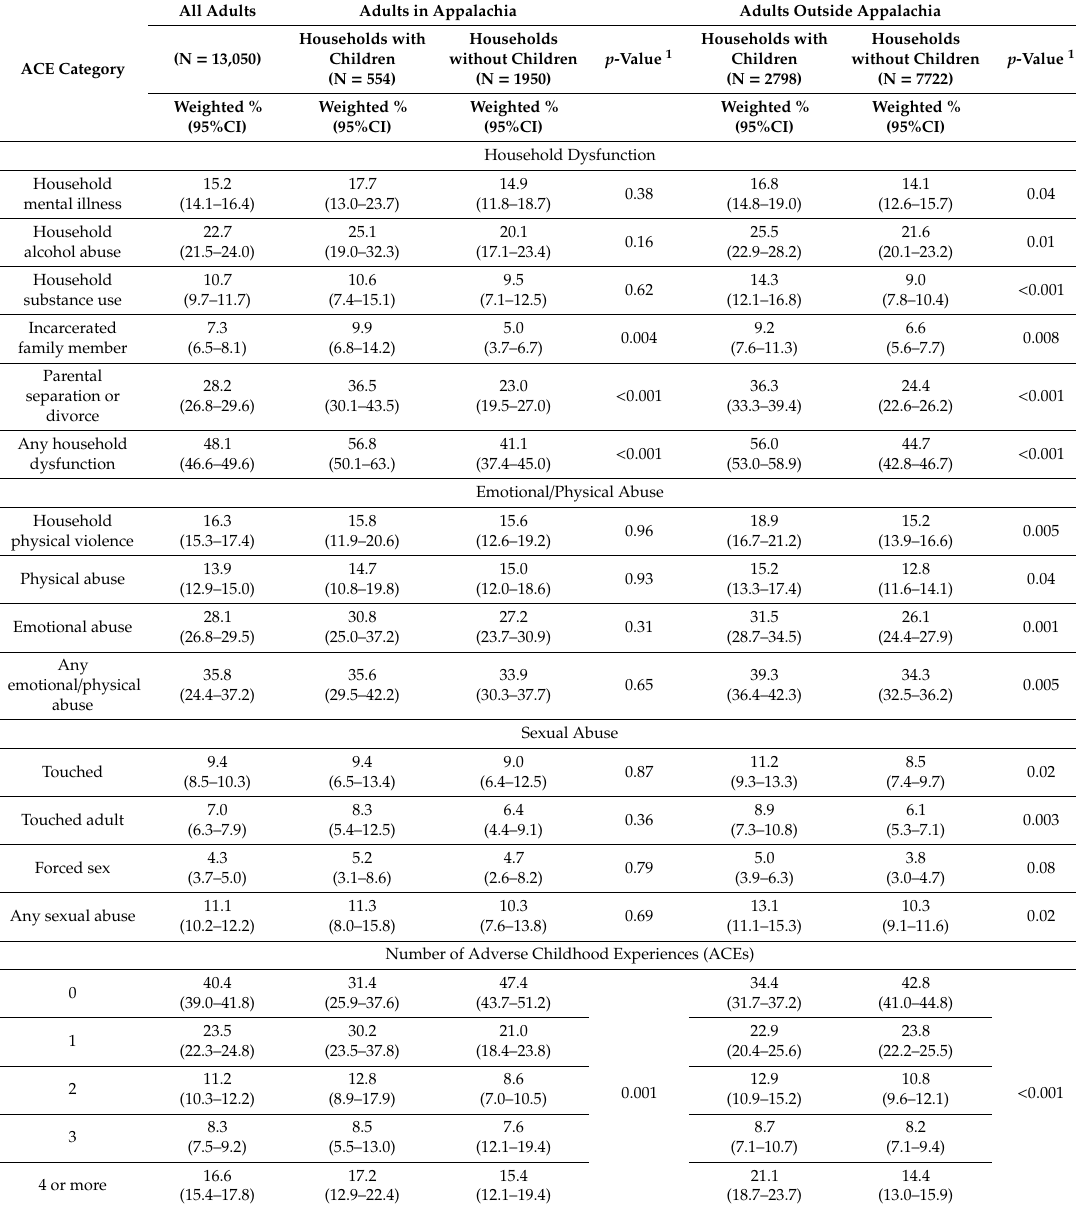
Table 1. Prevalence of ACEs among adults in North Carolina overall, by presence of children in the household, and by region, 2012 &